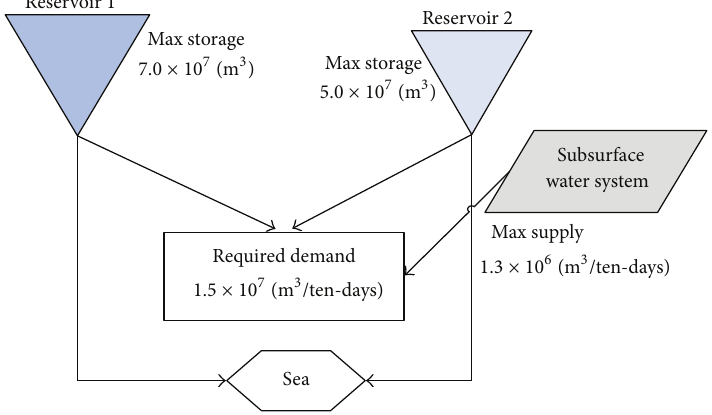
Figure 4: Schematic diagram of water resources